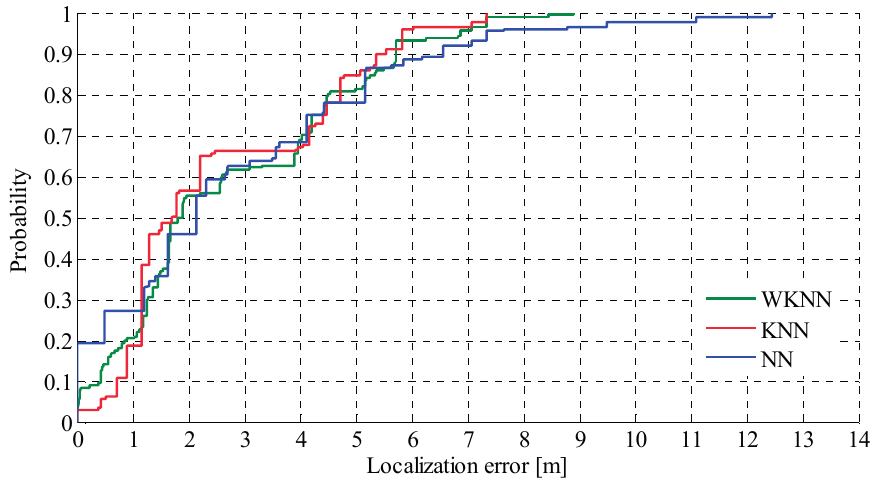
Figure 11. CDF of localization error in indoor